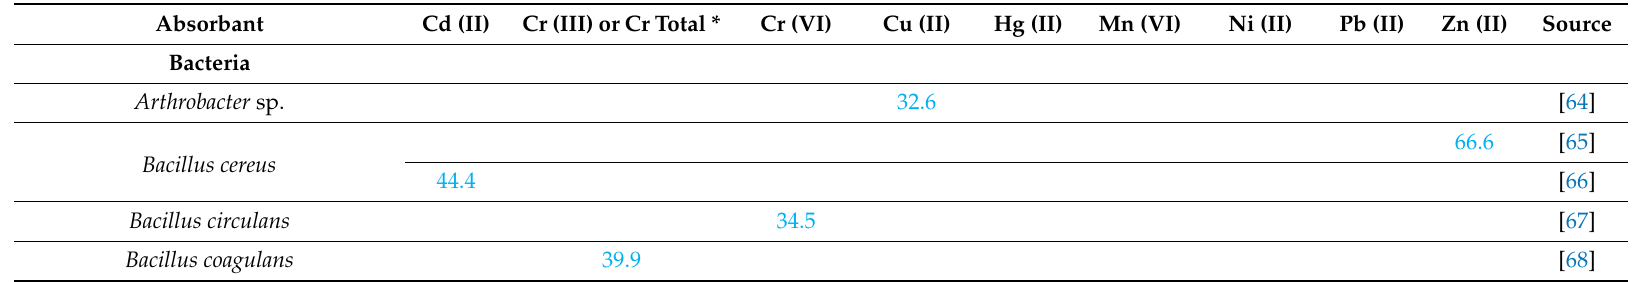
Table 2. Heavy metal removal potential of bacteria and fungi in the developing world, in mg / g or (% removal) (Peruvian studies in black color). SNS stands for “species not